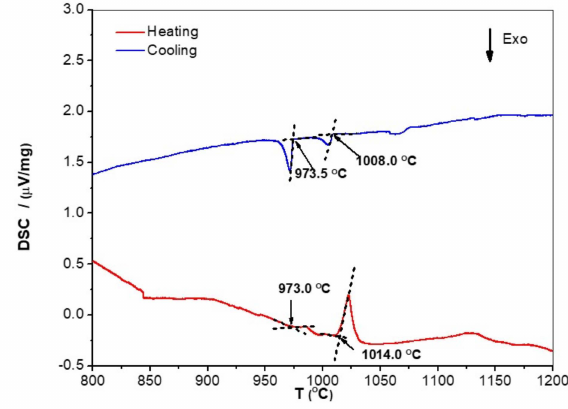
Figure 5. DSC trace of the alloy